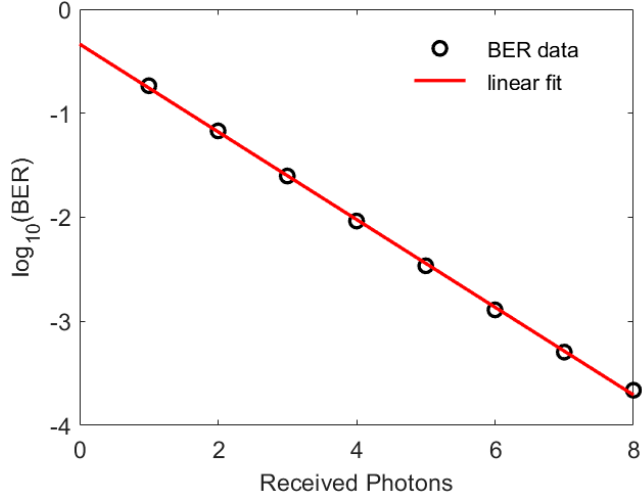
Figure 1. The number of recieved photons required to represent a logic one, N Tx , to achieve a range of BERs when N b = 0. The range of BERs shown is close to the value of 3.8 × 10 − 3 needed when forward error correction is used to significantly reduce the final BER. The results obtained with different integer numbers of additional photons are shown as black circles. The red line is then a linear fit to the points.